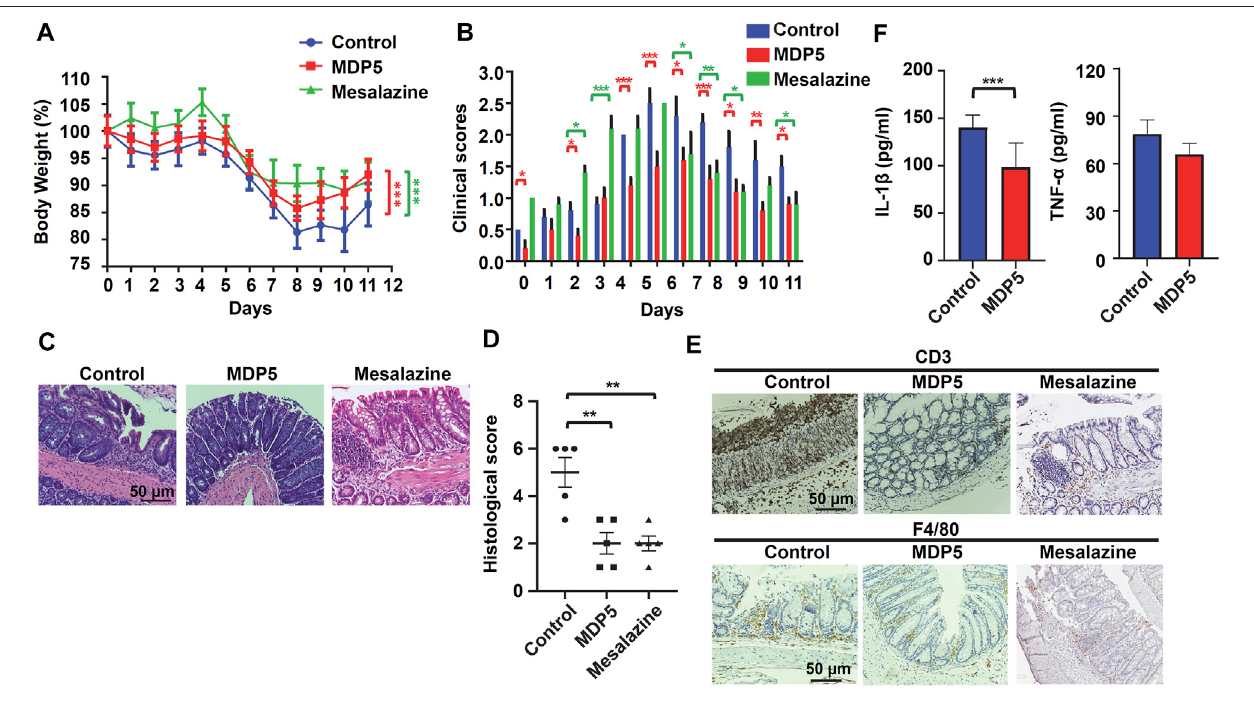
FIGURE 6 | MDP5 alleviated DSS-induced colitis in mice. Mice were orally gavaged with MDP5 (20 mg/kg) or mesalazine (20 mg/kg) and colitis was induced with 3% DSS for 5 days ( n (cid:1) 5 per group). (A) Percentage of body weight. (B) Clinical scores. (C,E) Images of H&E-stained (C) and immunohistochemistry-stained (E) colon sections from mice scari fi ed on day 11. Intestinal in fl ammation, in fi ltration of immune cells and quantities of cytokines were assessed by histological scoring (D) , immunochemistry staining (E) , and ELISA (F) , as described in the Methods section. Data were analyzed using the Student ’ s t -test (two-tailed) (A,D,F) or two-way ANOVA with the multiple comparison test (B) .* p < 0.05, ** p <